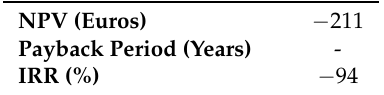
Table 8. State-of-the-art Collector’s Indicators (Euros).